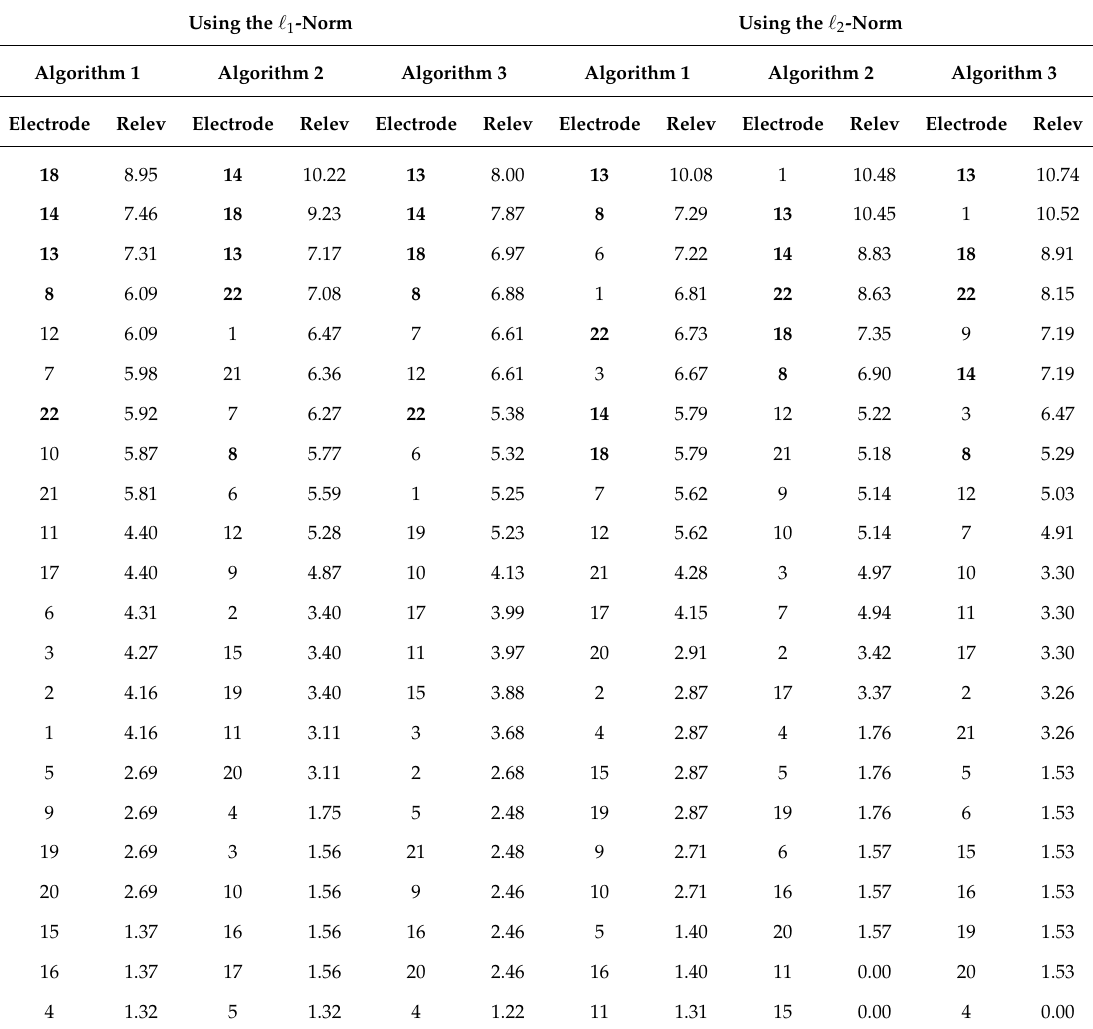
Table 4. Results of selection of BCI channels applying the Algorithms 1 to 3 with (cid:96) 1 -norm and (cid:96) 2 -norm. Using the (cid:96) 1